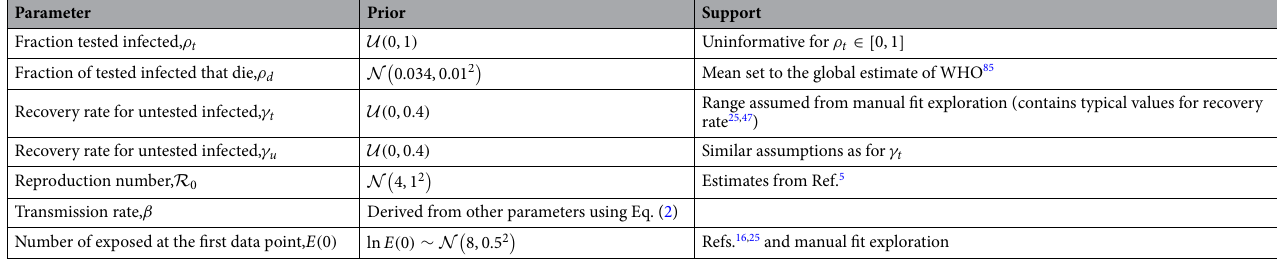
Table 1. Assumptions for the prior probability distribution of the estimated parameters.